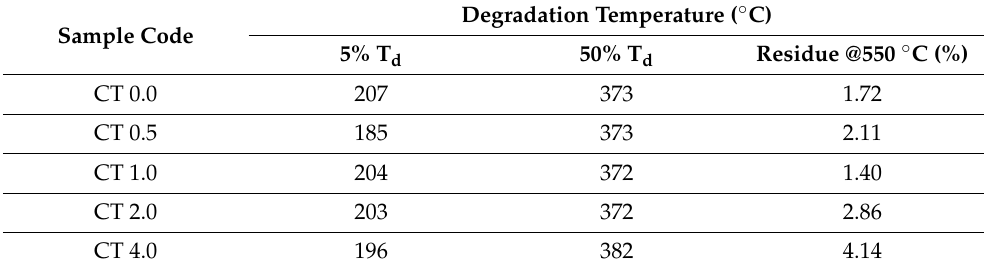
Table 3. Thermal Degradation Data of NIPU Composites .